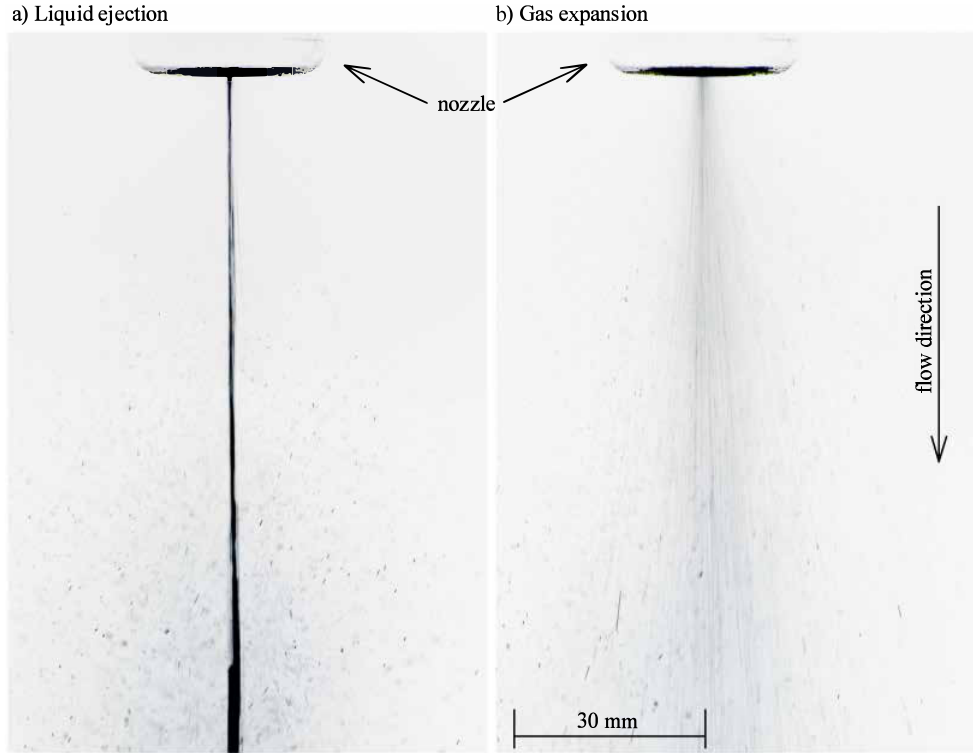
Figure 10. Example of the viscous liquid spraying by the CFT atomizer at GLR = 2.5% (similar spray patterns were observed for the OIG atomizer under the same working